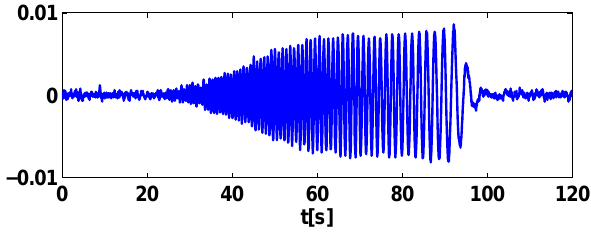
Fig. 8. Measured time signal at X obs = 10m of the focussing wave.